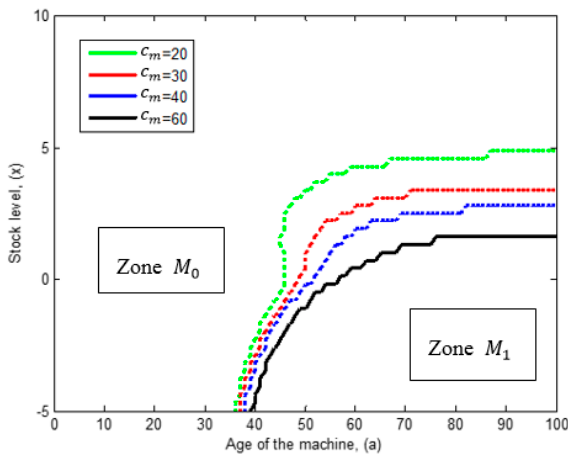
Figure 9. Sensitivity of the major maintenance cost on the repair/major maintenance policy.